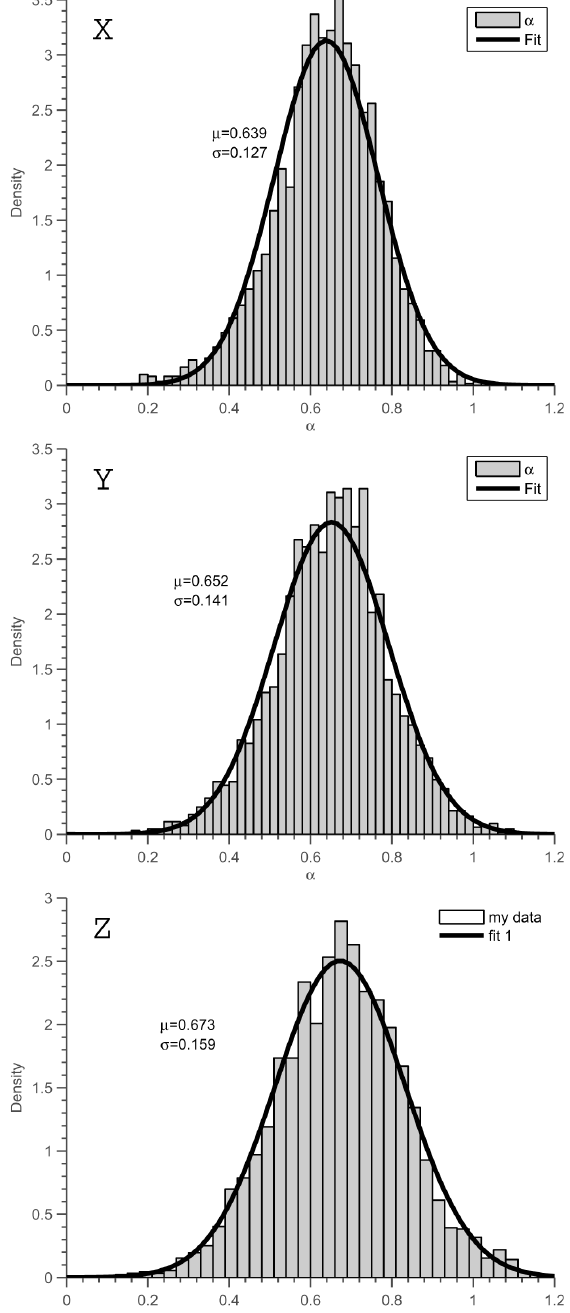
Fig. 5. Distributions of the fractal scaling exponent for active events, for all latitudes. These data are fitted to a normal distribution (solid black), with the mean and standard deviation given in the